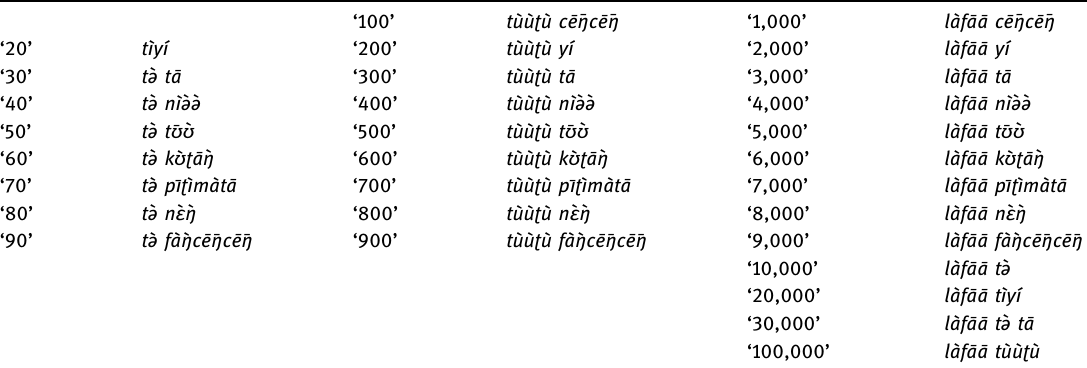
Table 4: Akebu complex